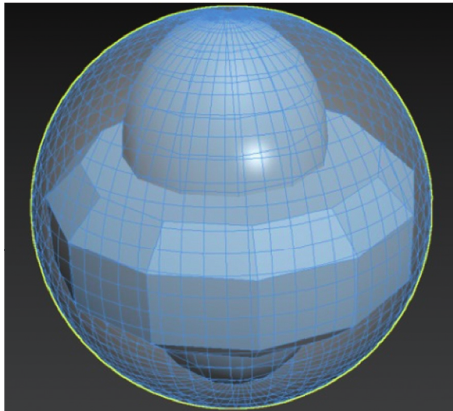
Figure 5: The outer sphere.